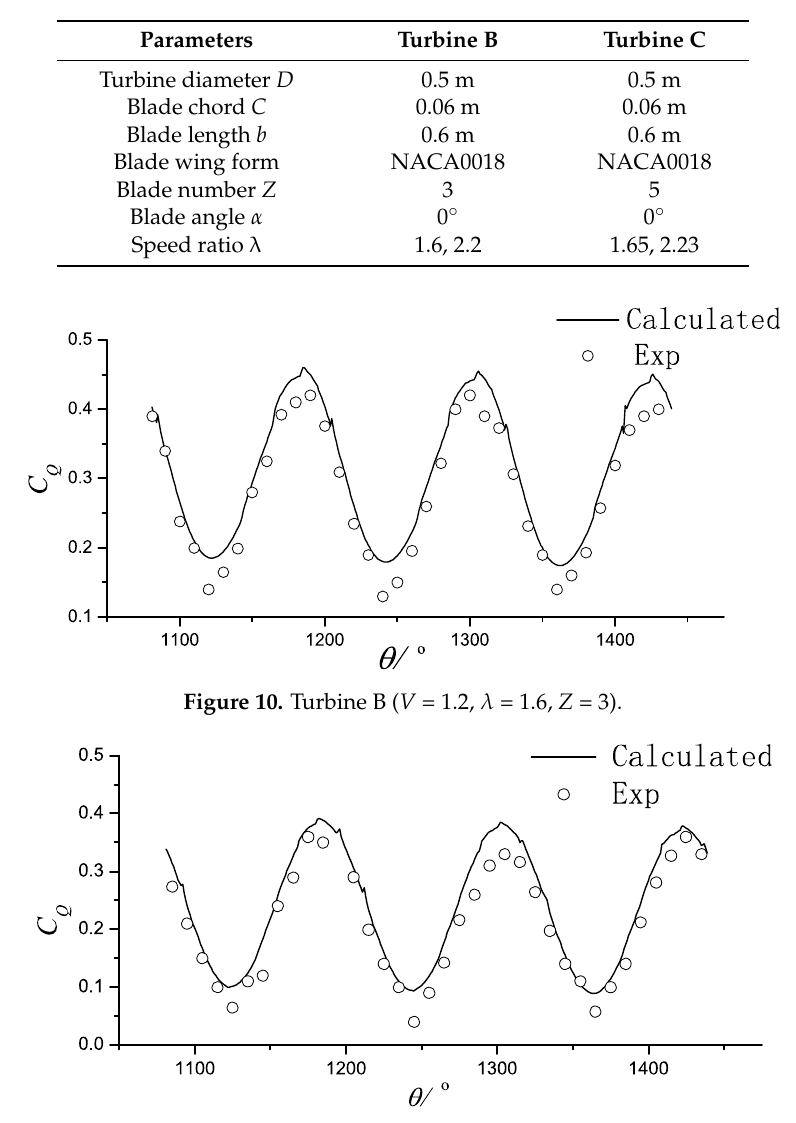
Figure 11. Turbine B ( V = 1.2, λ = 2.2, Z = 3).